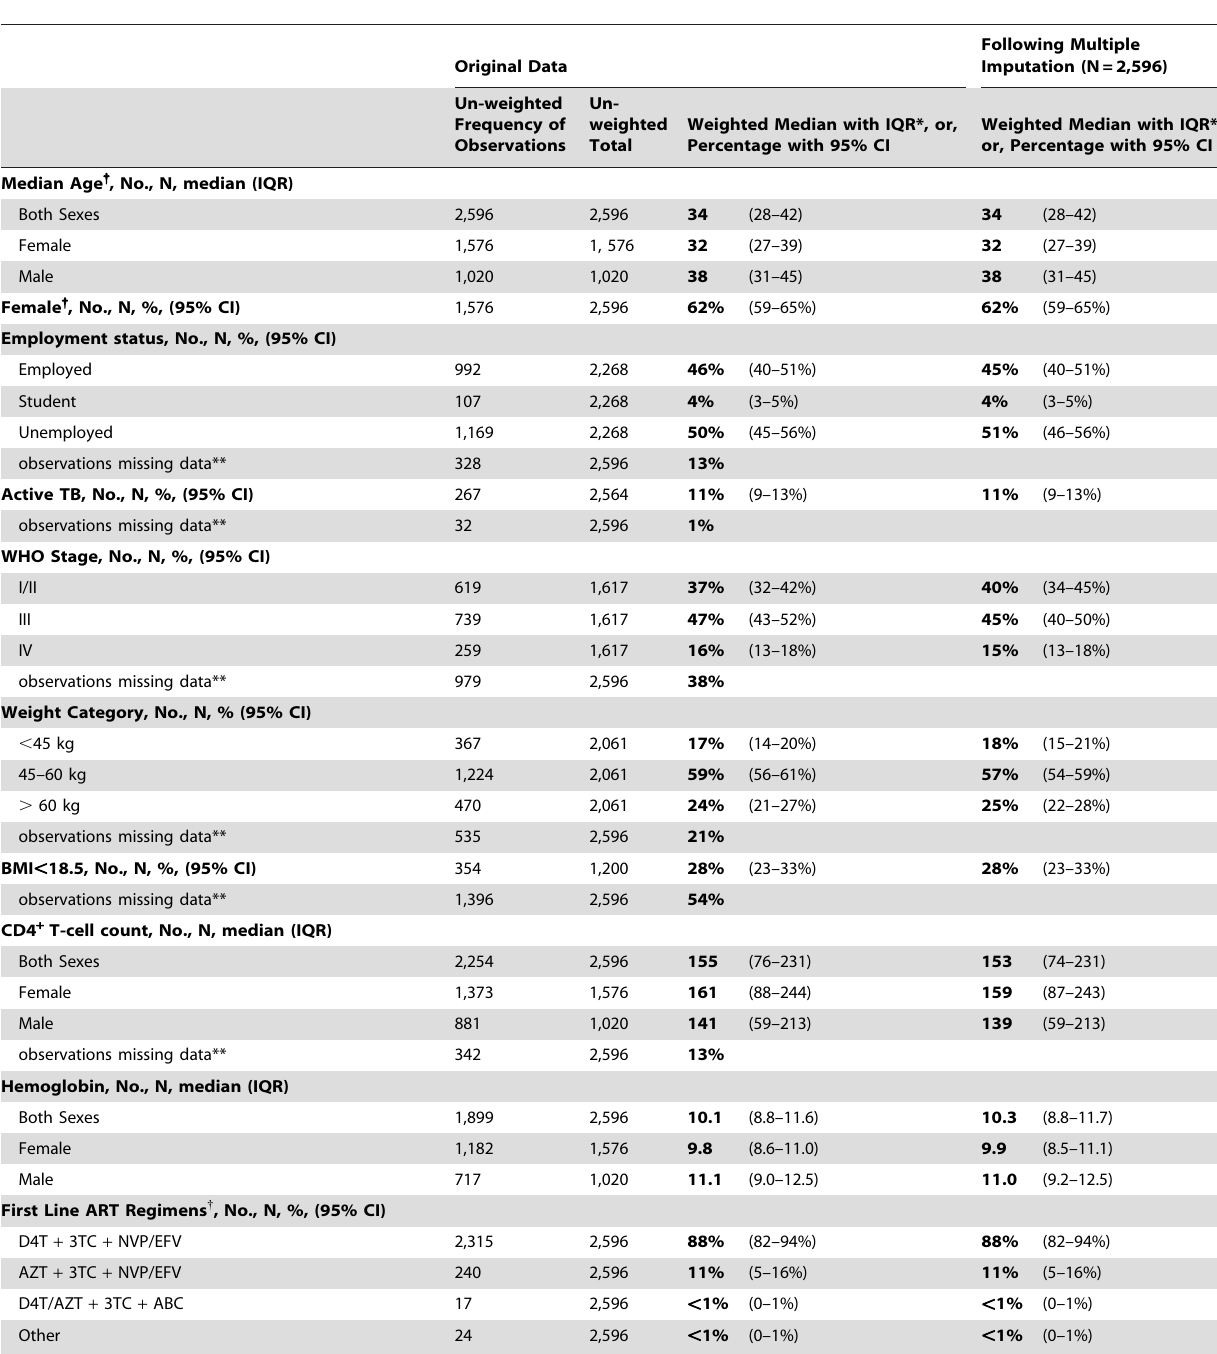
Table 1. Demographic and clinical characteristics of adult patients at ART initiation – Mozambique,